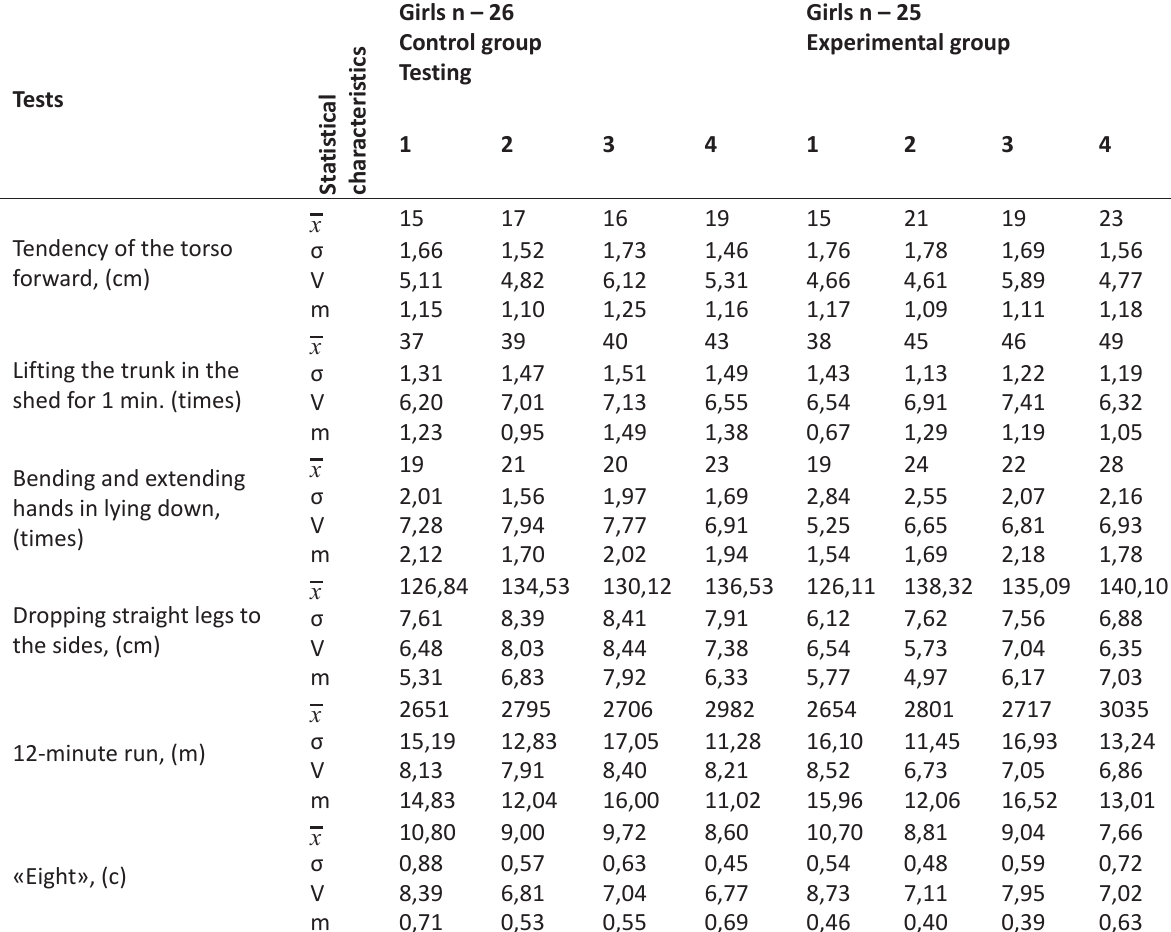
Table 2. Statistical values of indicators of girls’ motor qualities development of aged 17-20 years during the experiment